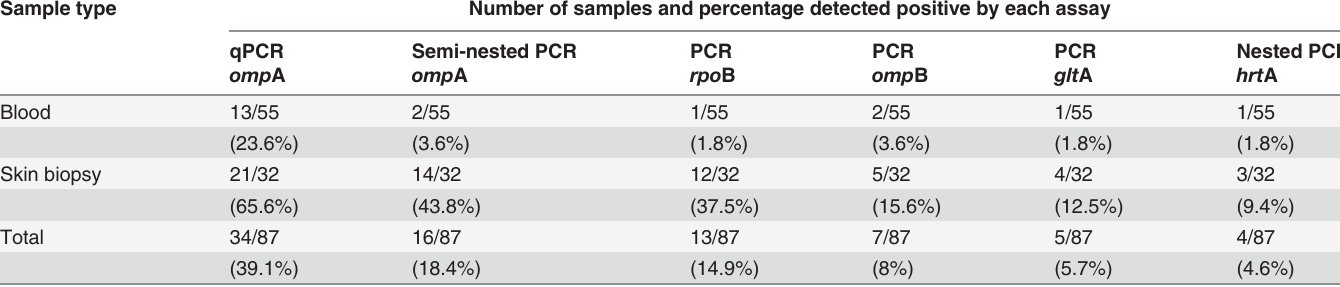
Table 2. Relative sensitivity of 5 conventional PCRs and SYBR green real-time PCR. Sample